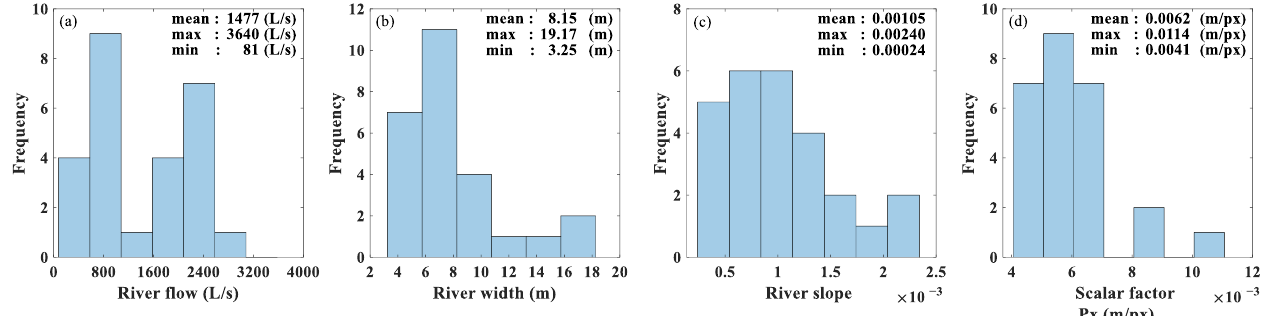
Figure 2. Histograms of the main characteristics of the 27 case studies in consideration. ( a ) river discharge with a mean value equal to 1477 (L/s); ( b ) river slope with a mean value equal to 0.00105 (m/m); ( c ) river width with a mean value equal to 8.15 (m); and ( d ) scalar factor from pixel to meter unit with a mean value equal to 0.0062 (m/px).